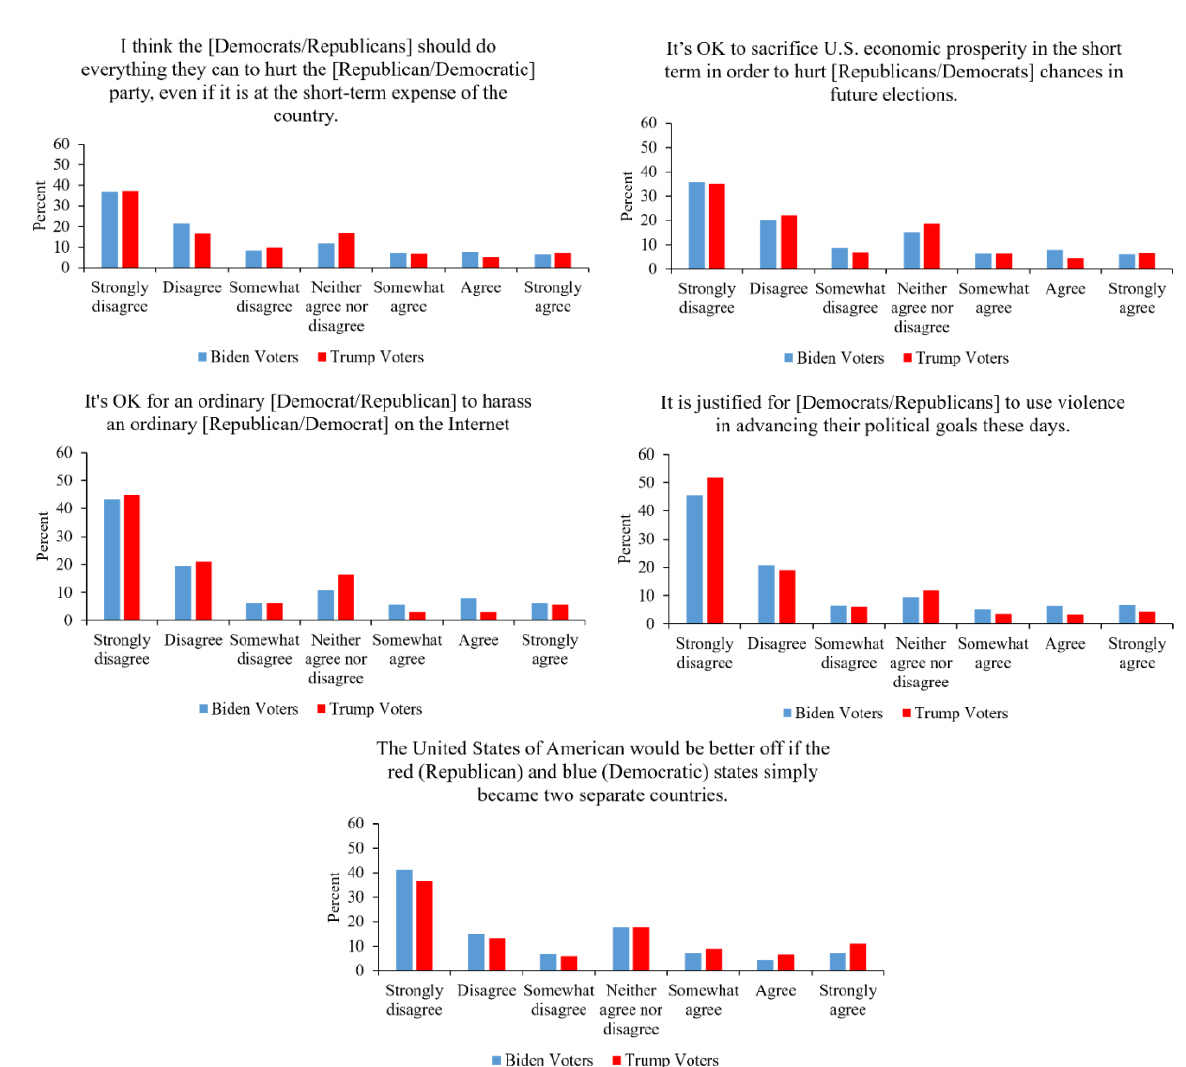
Figure 5. Partisan violence and spite. Percent of Biden (blue) and Trump (red) voters ’ views on select questions relating to partisan spite (top panel) and violence (middle panel). A minority of both Trump and Biden voters wish to break the United States up along party lines (bottom panel). Note that the question wording has been slightly shortened here in some